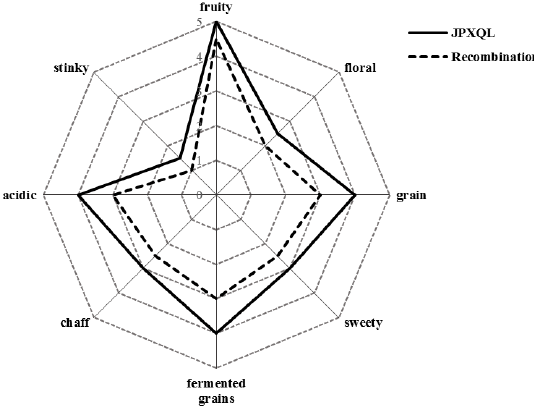
Figure 2. Profile of aroma recombination of JPXQL. Figure 2 . Profile of aroma recombination of JPXQL.